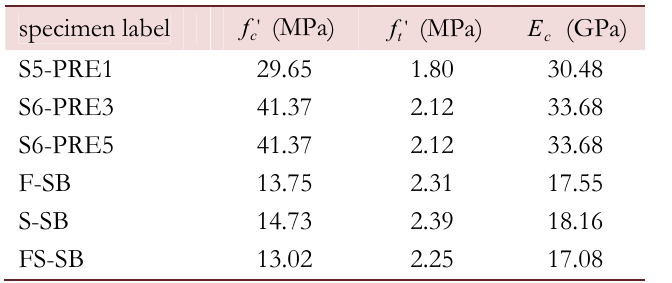
Table 2: Material properties of concrete of the analysed specimens